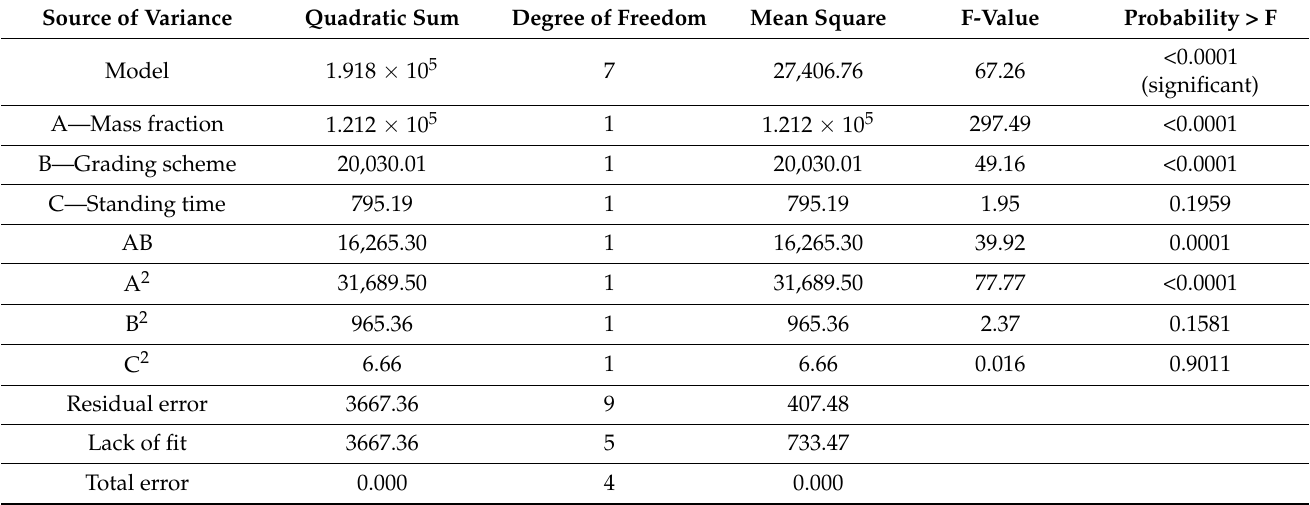
Table 11. Variance analysis results of the response surface analysis and the fitting regression equation.